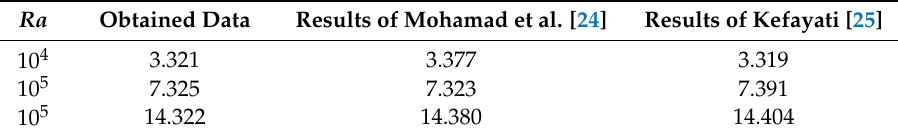
Table 2. Mean Nu at heated border compared with results of other authors.